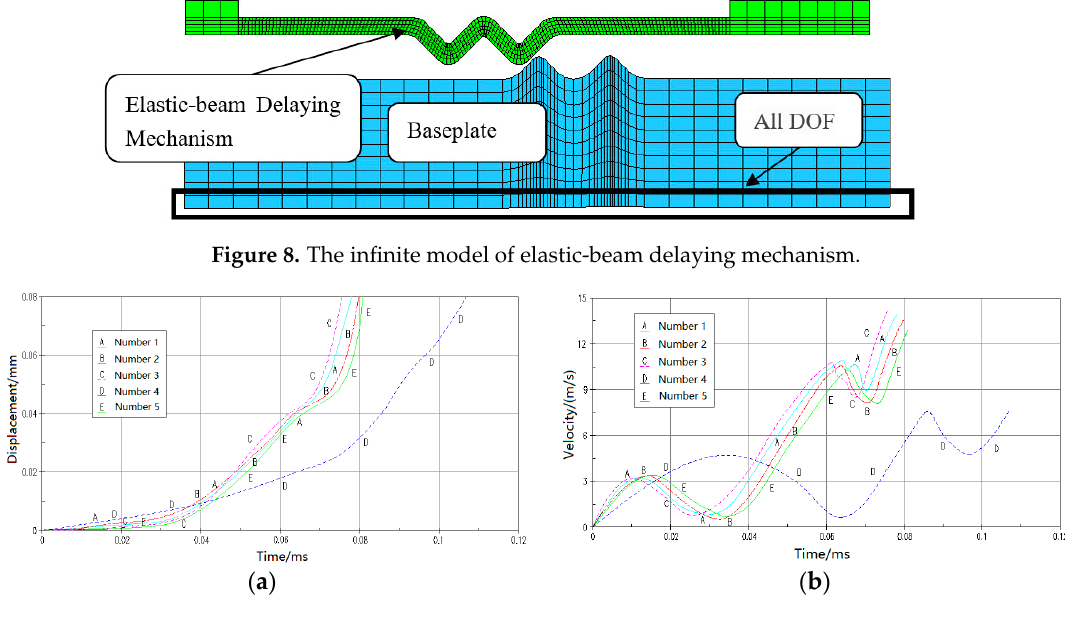
Figure 9. The simulation results of different structural parameters ( a ) displacement-time curves ( b ) velocity -time curves. Table 4. The maximum deformation and error between theoretical results and simulation results.